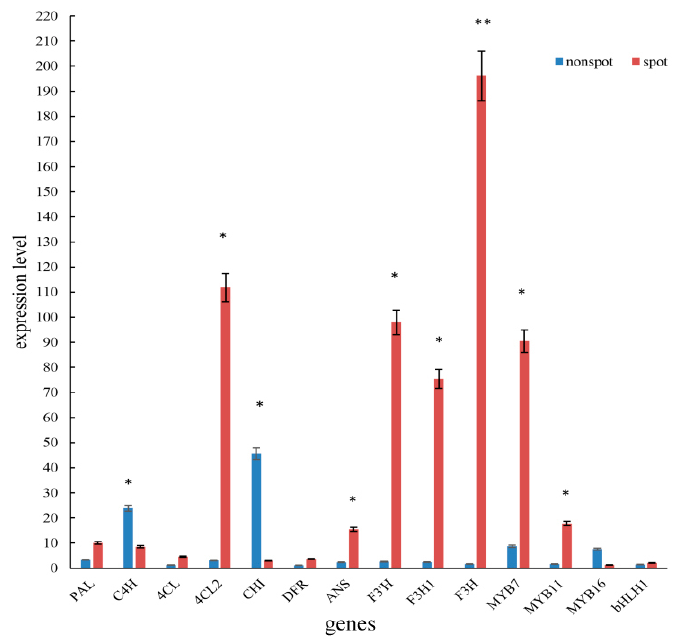
Figure 6. The expression level of structure gene and regulate gene Associated with Anthocyanin Biosynthesis, * represent there are significant differences between spot and non-spot area; ** represent there are extremely significant differences; red: spot area, blue: non-spot area.